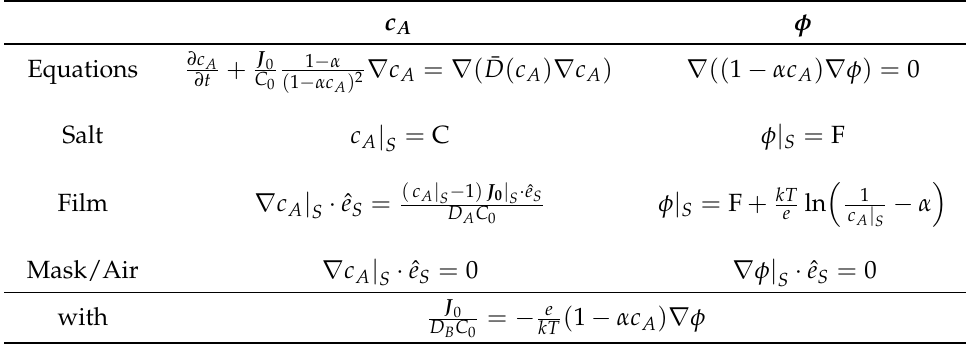
Table 2. Complete formulation of the IE problem (equations and boundary conditions), for the most common IE processes, in terms of the normalized concentration of dopant cations c A and an effective electric potential φ ; ˆ e S is a unit vector perpendicular to the sample surface, and C and F are